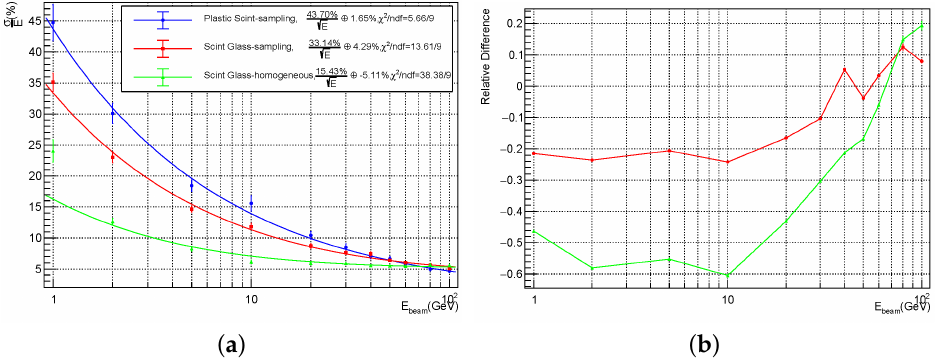
Figure 3. Performance with single neutral kaons ( K 0 ) in the kinetic energy range from 1 GeV to L 100 GeV perpendicular to the incidence ofthe calorimeter surface: ( a ) hadronic energy resolutions with different sensitive materials; ( b ) relative differences of hadronic energy resolutions with scintillating glass compared with with 3 mm plastic scintillator and 20 mm steel.